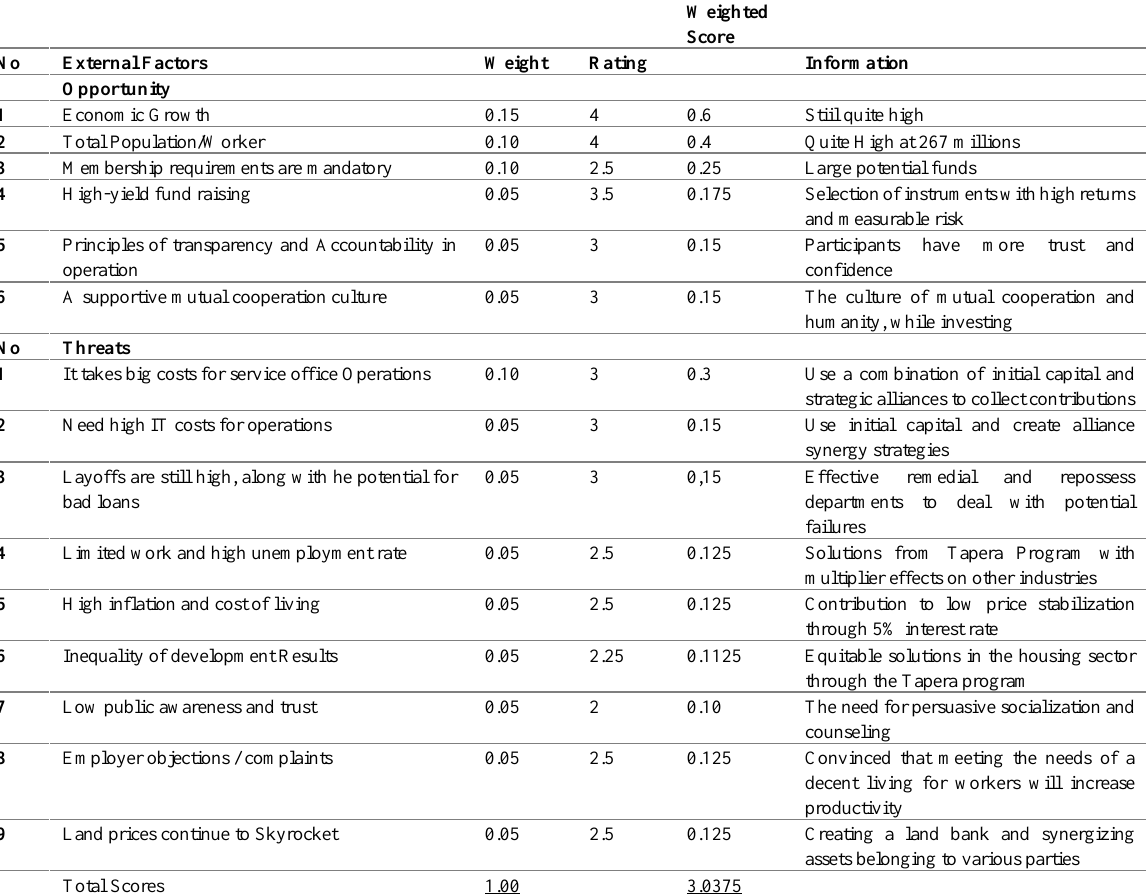
Table 2: EFAS of Program Tapera